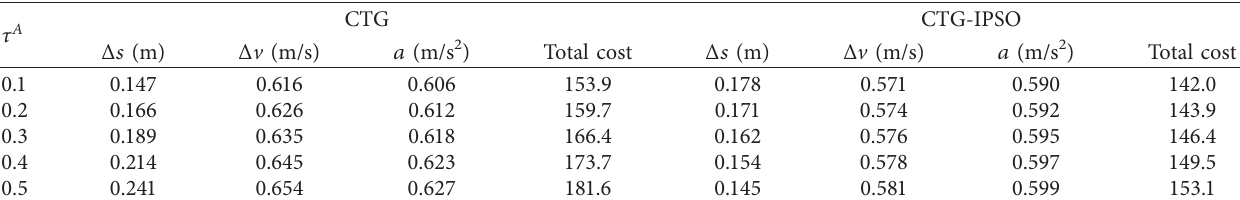
Table 5: Sensitivity analysis of actuator lag of CTG and CTG-IPSO.